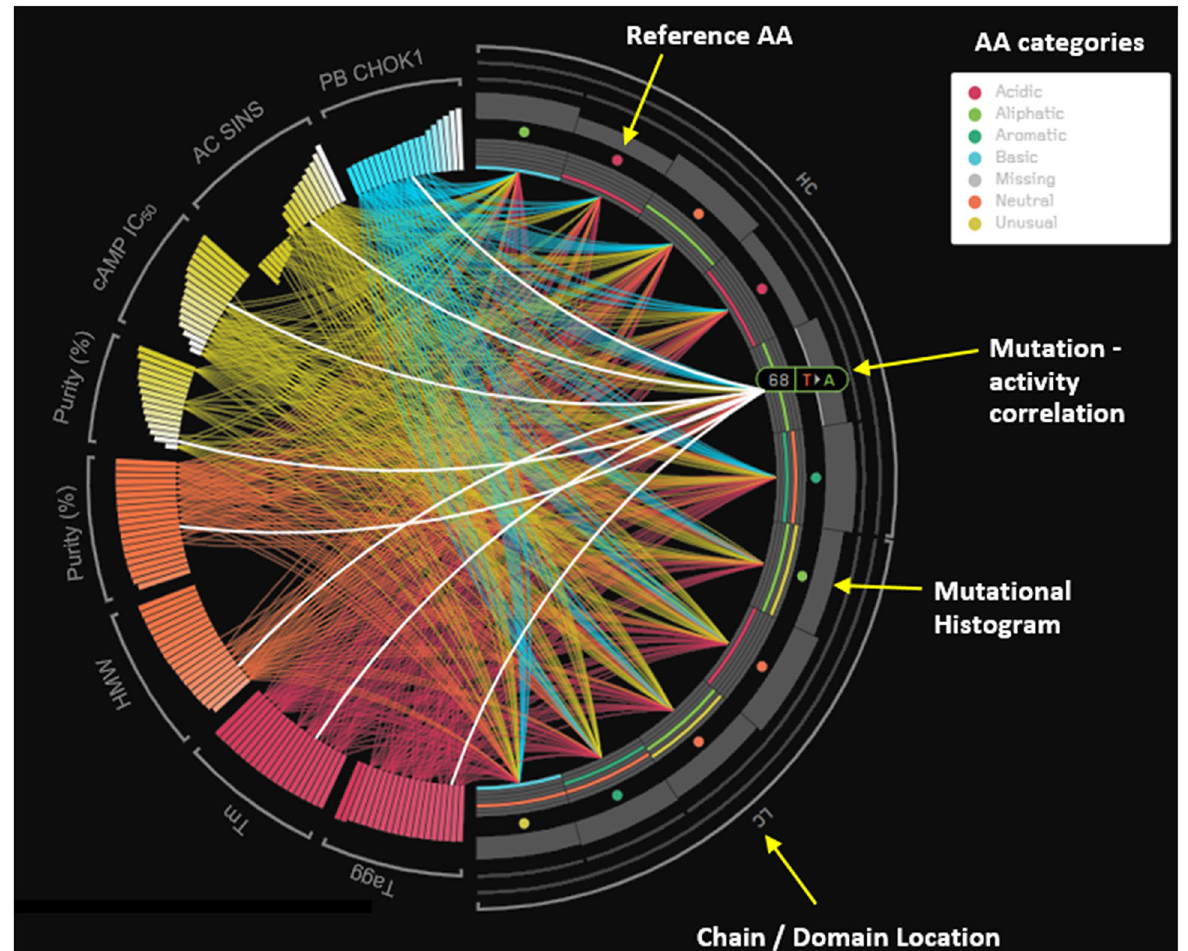
Fig. 12 Realignment of the radial graph showing multi-sequence alignment comparisons across all molecule candidates mapped to experimental measurement